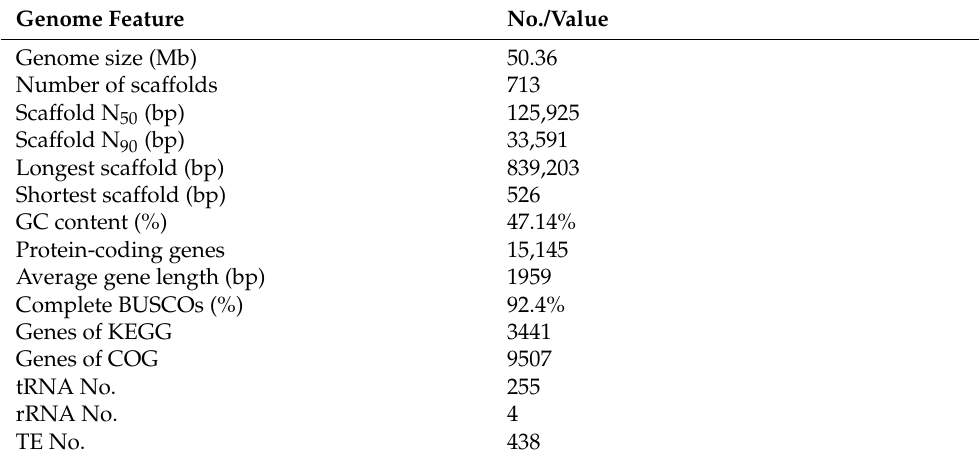
Table 2. Genome feature of the Desarmillaria tabescens CPCC